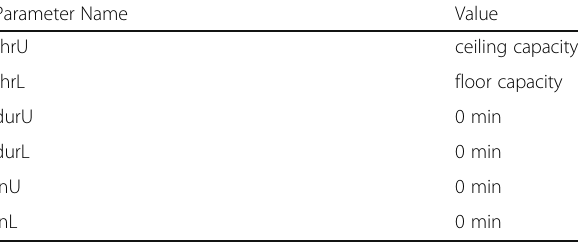
Table 4 The parameters of the rule-based decision maker